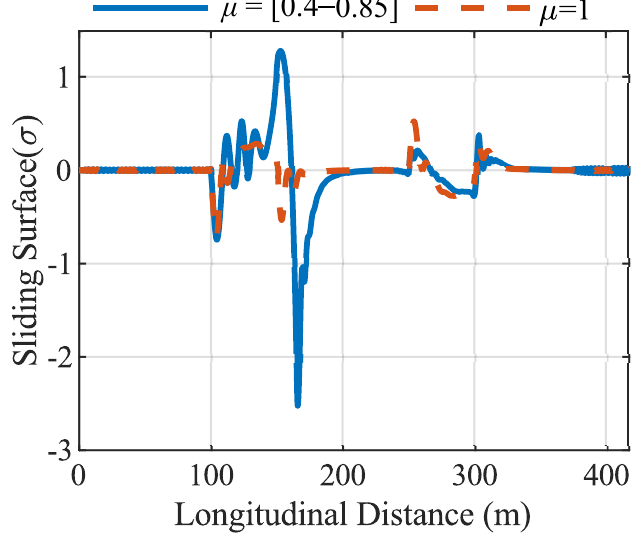
Figure 10. The effect on sliding surface for v x = 100 km/h for a variety of road conditions, µ ∈ [ 0.4–0.85 ] and µ = 1.